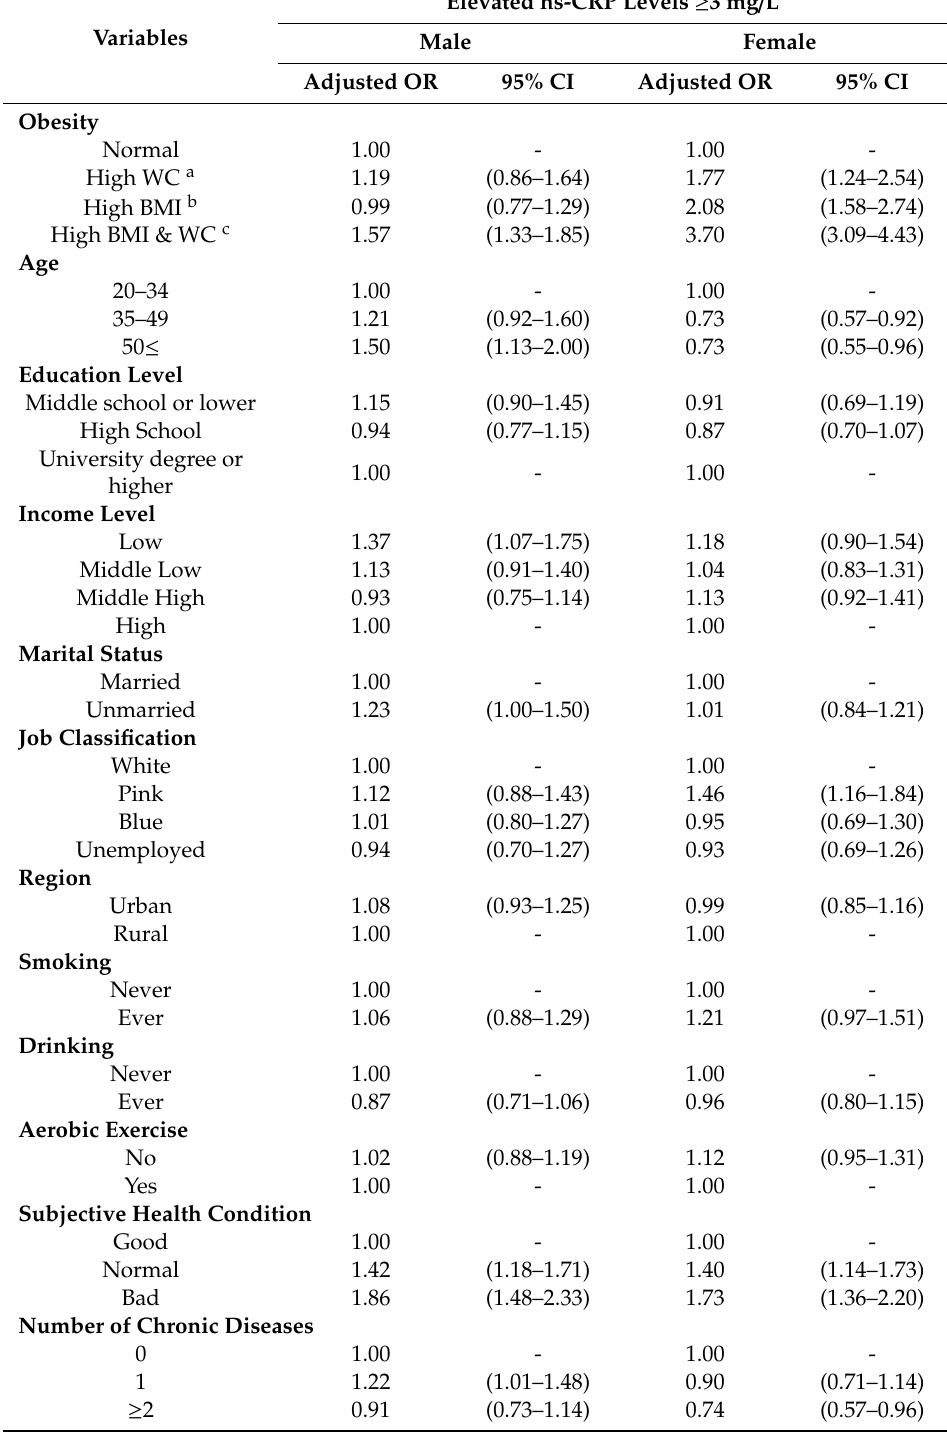
Table 2. Association of BMI and WC with elevated high-sensitivity C-reactive protein (hs-CRP)